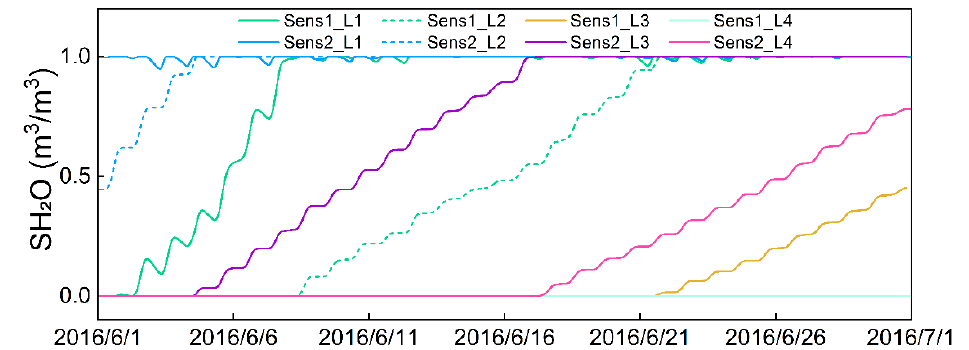
Figure 7. Comparison between the Sens1 and Sens2 estimates of the liquid water content (SH 2 O) in the first (L1), second (L2), third (L3), and fourth layer (L4) in June 2016 in the ablation region of the Parlung No. 4 Glacier.